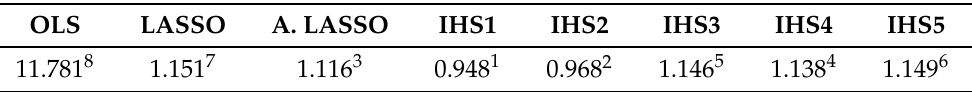
Table 15. Mean square error for different estimators for Body Fat Prediction data (superscript represents